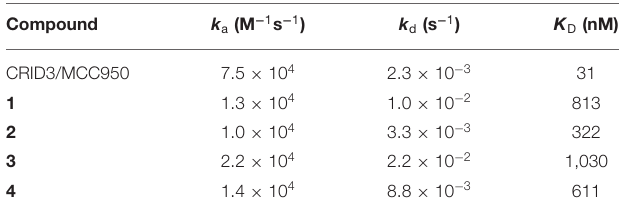
TABLE 1 | Second-order on-rate constants for association ( k a ), first-order off-rate constants for dissociation ( k d ), and kinetic dissociation constants ( K D ) for NLRP3